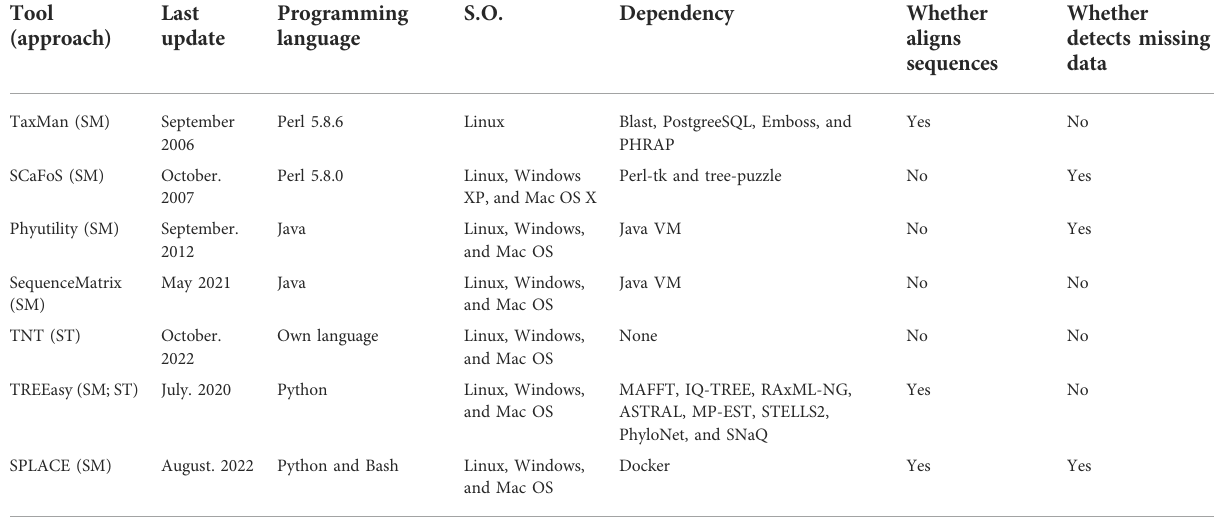
TABLE 1 Summary of tools developed to aid in phylogenetic/phylogenomic analyses. The approach used by each tool is given in